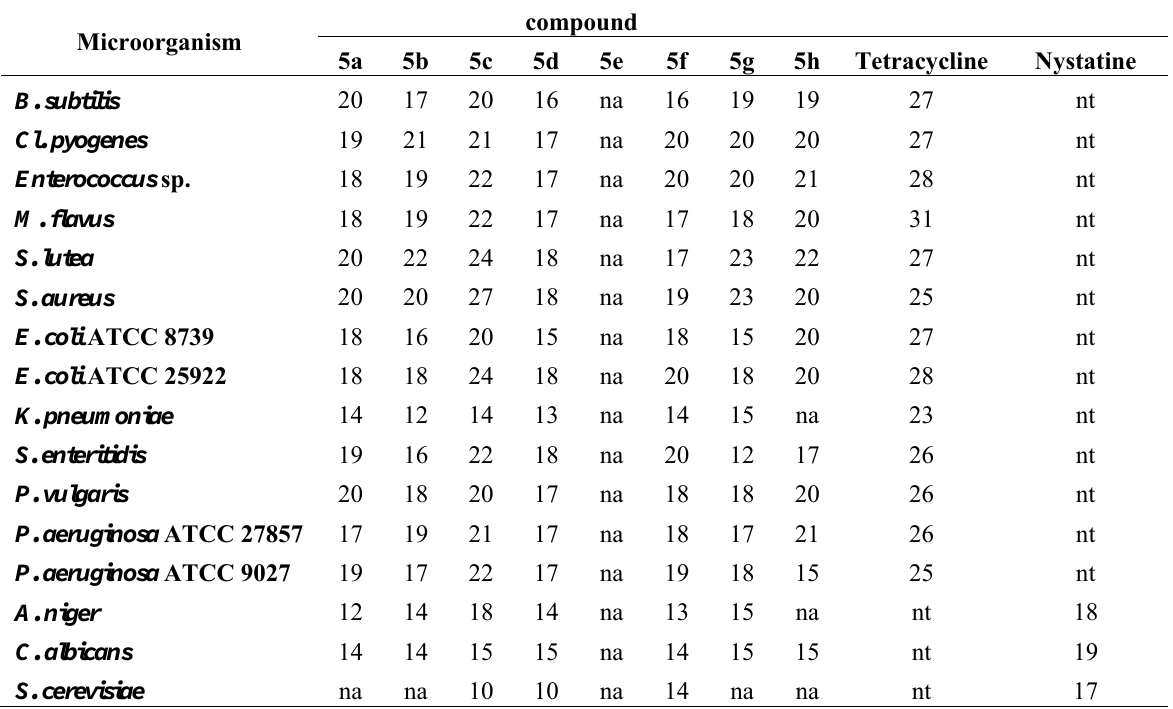
Table 2. The antimicrobial activity - diameters of growth inhibition zones of compounds 5a–h in a disk diffusion assay at a dose of 500 μ g per disk.